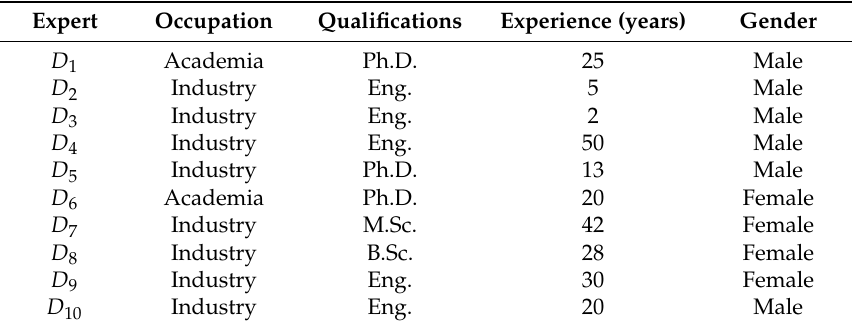
Table 4. The information about the invited railway